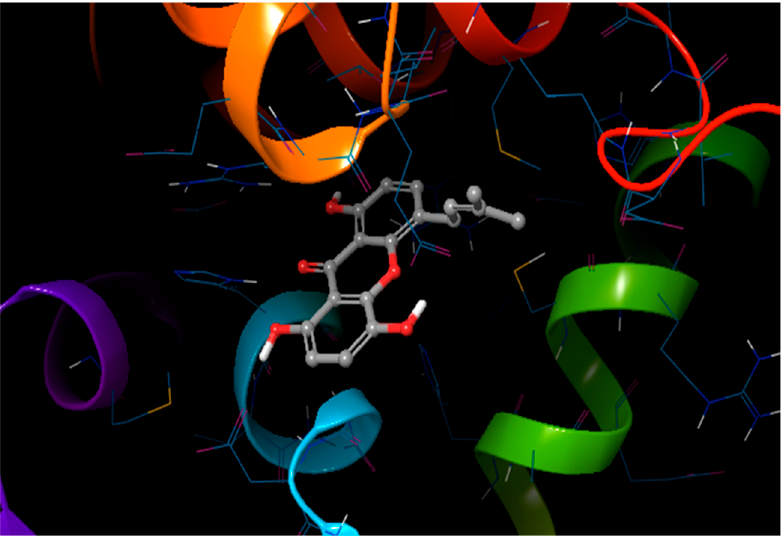
Figure 7. The induced fit pose of ZINC000095485921 (grey) in metal binding site 2 of the ideR of M. ulcerans model.